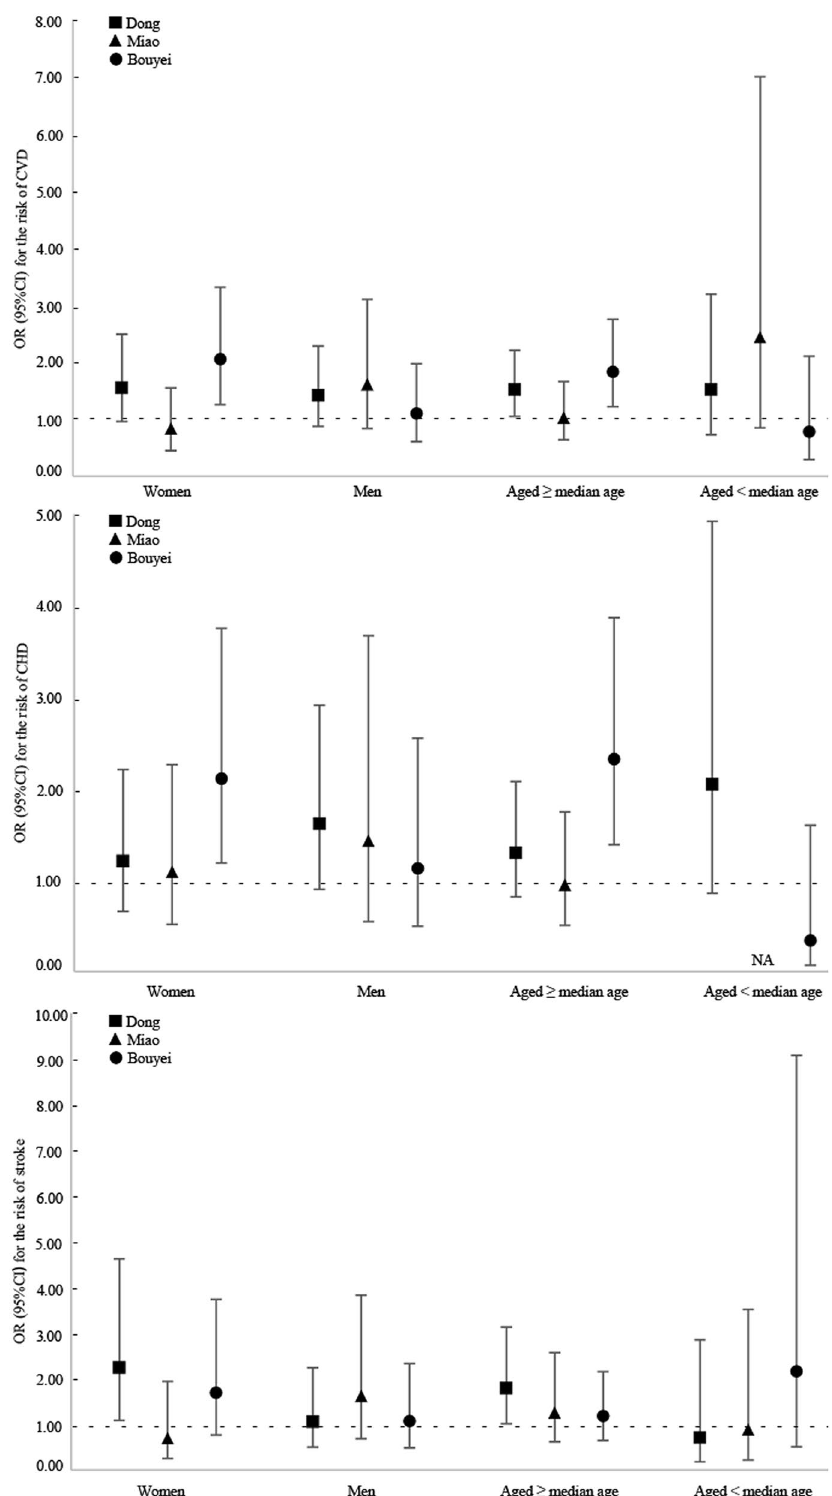
Figure 3. Risk of cardiovascular disease, coronary heart disease, and stroke stratified by sex and age in rural areas. Adjusted for sex, age, educational attainment, annual household income, tobacco smoking status, alcohol drinking status, total physical activity, total energy intake, family history of cardiovascular disease, body mass index, and systolic blood pressure, fasting plasma glucose, and triglycerides levels, except for the stratified variables. CHD coronary heart disease; CI confidence interval; CVD cardiovascular disease; NA not applicable; OR odds ratio. Median of age were 53, 51, and 51 years among the Dong, Miao, and Bouyei ethnic groups,